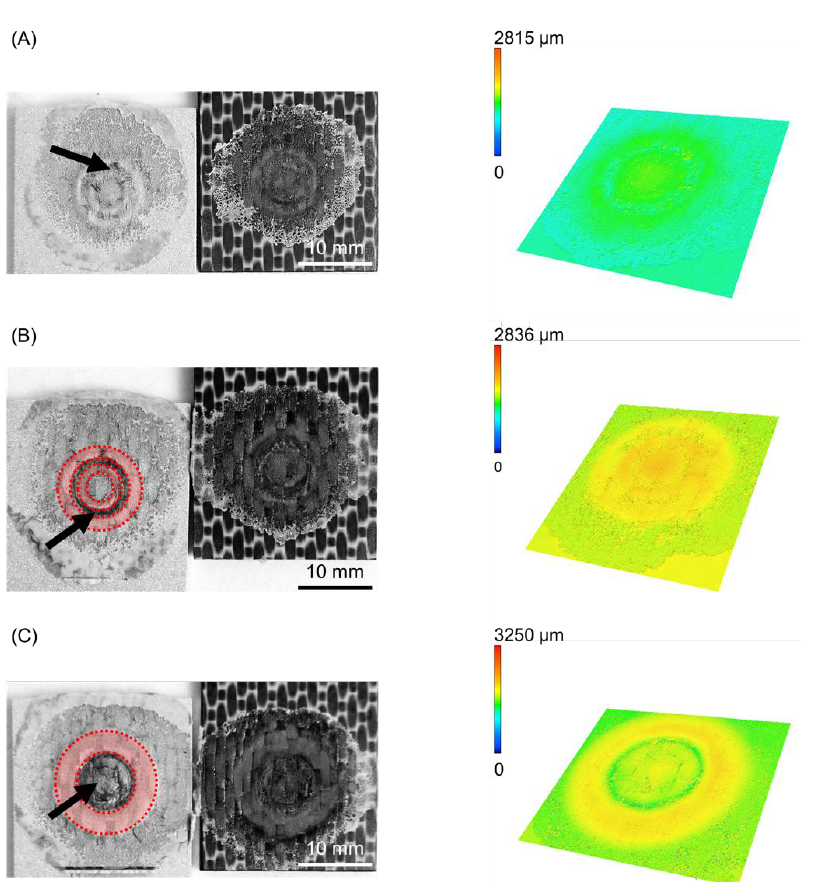
Figure 10. Fracture surface and 3D image of the deformation on the aluminum part (nub region) for the joints produced with ( A ) 4 kN, ( B ) 6 kN and ( C ) 8 kN of joining force (constant joining parameters RS: 1900 rpm, PD: 0.8 mm, JT: 4 s). Materials 2018 , 11 , x FOR PEER REVIEW